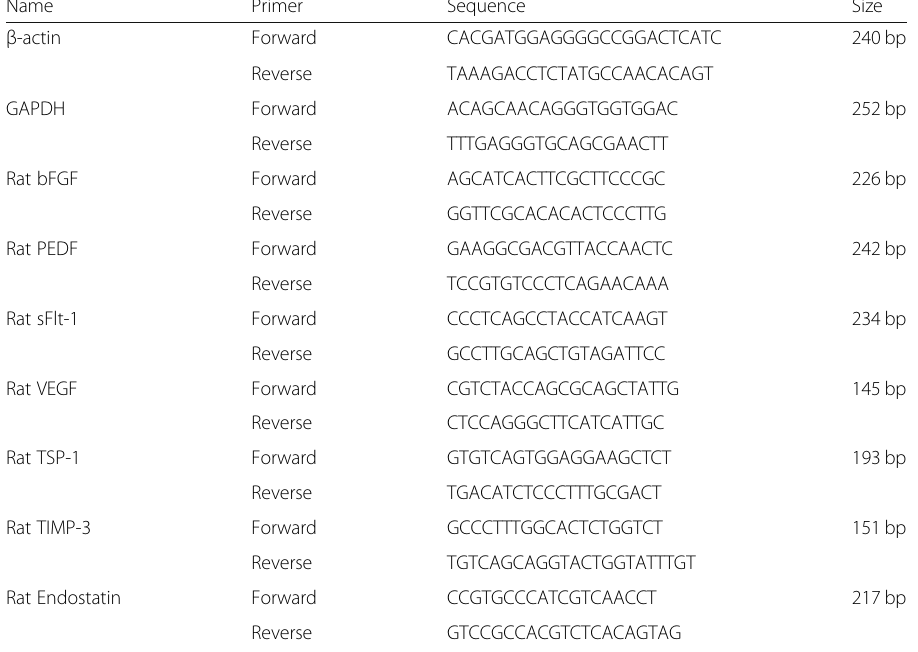
Table 2 Primer sequences used for RT-qPCR